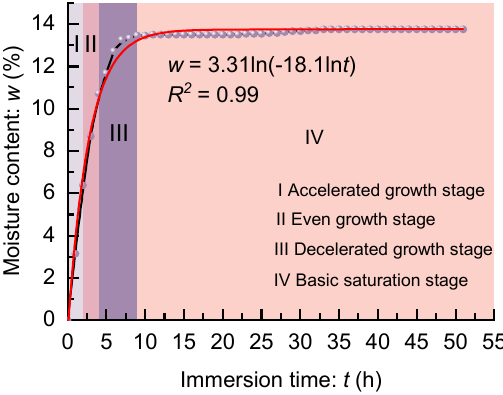
Figure 6. Water content–immersion time